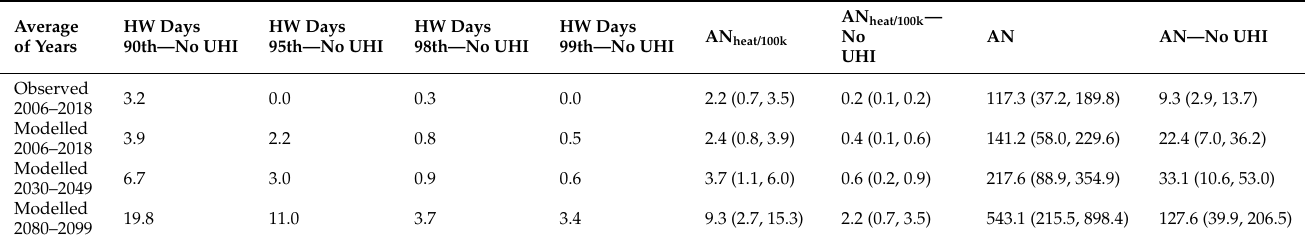
Table 3. Average annual observed (Australian Water Availability Project) and projected (NSW and ACT Regional Climate Modelling) heatwave (HW) days with no urban heat island (UHI) ef- fect, and numbers of heatwave-attributable deaths (AN) in Sydney Greater Metropolitan Region (GMR) with and without the UHI effect.